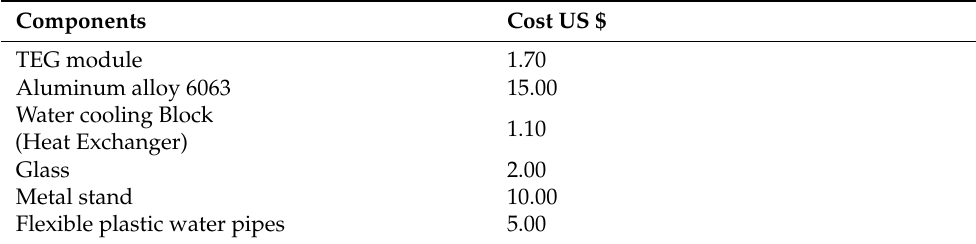
Table 3. Component costs of the TEG